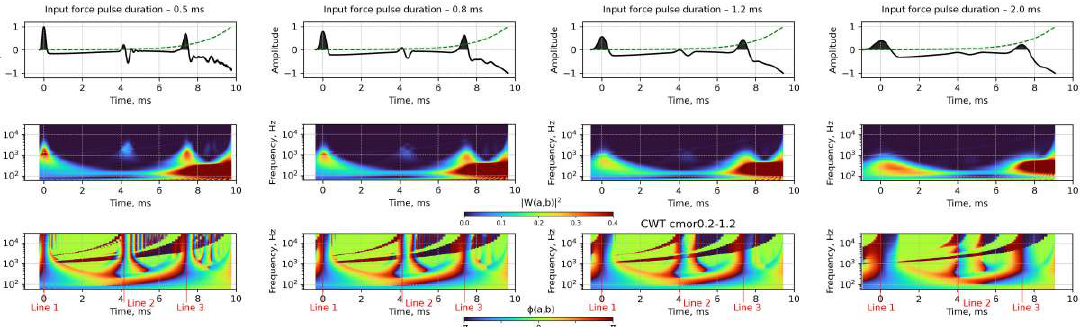
Figure 5. CCWT analysis of the low strain test numerical simulation results for a pile with a splice of 5 mm sand gap (Model 2) with input force pulses of 0.5, 0.8, 1.2, and 2 ms duration. 1st row—the simulated signals, 2nd row—the distributions of energy of the wavelet transform coefficients, 3rd row—the distributions of phase angles of the wavelet coefficients. Lines 1, 2, and 3 delineate the phase shift